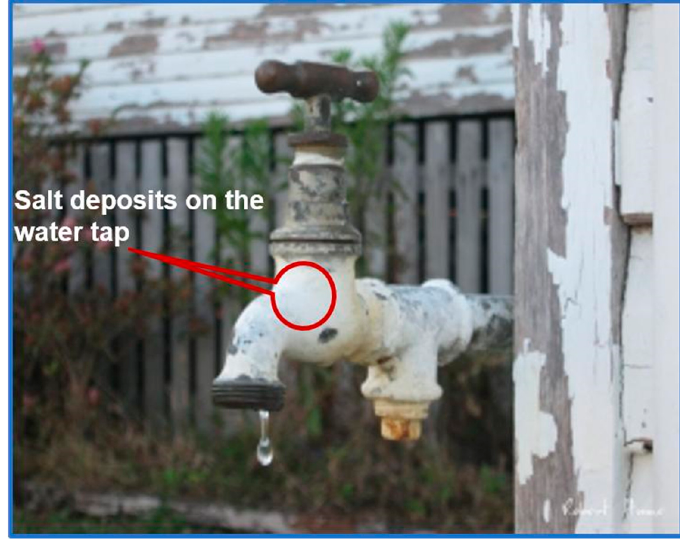
Figure 1. A picture showing public water tap with a salt deposit in Limpopo Province, South Africa.